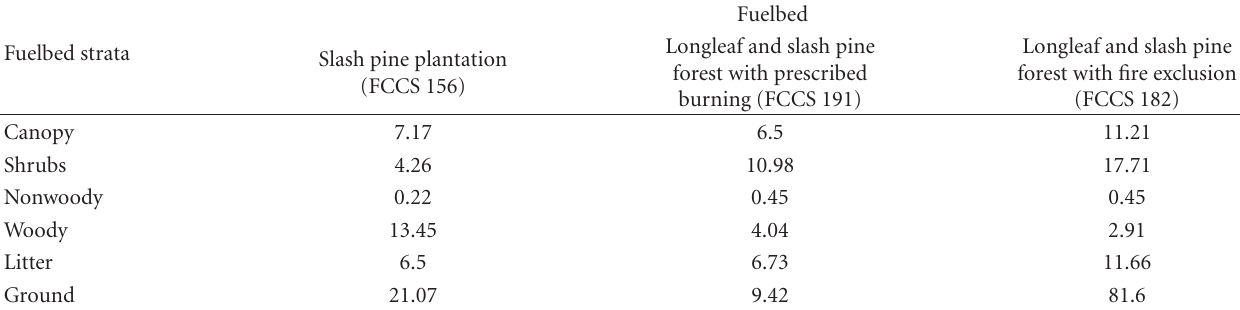
Table 3: Fuel load (Mgha − 1 ) for typical pine fuelbeds in the southeastern United